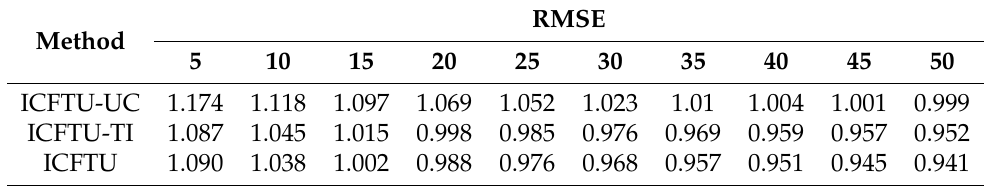
Table 4. The results of the ablation experiment of